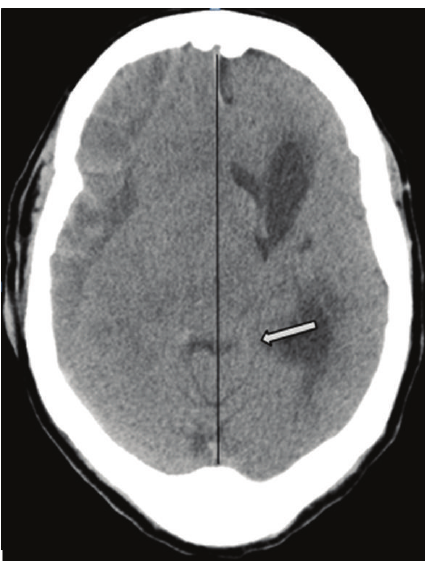
Figure 1: CT of the head showing gross posterior and lateral dis- placement of midbrain with deformity of the crus cerebri (pointed by the arrow) to the left side. The midline is marked with a black line. The subdural hematoma is visible on the right-side.